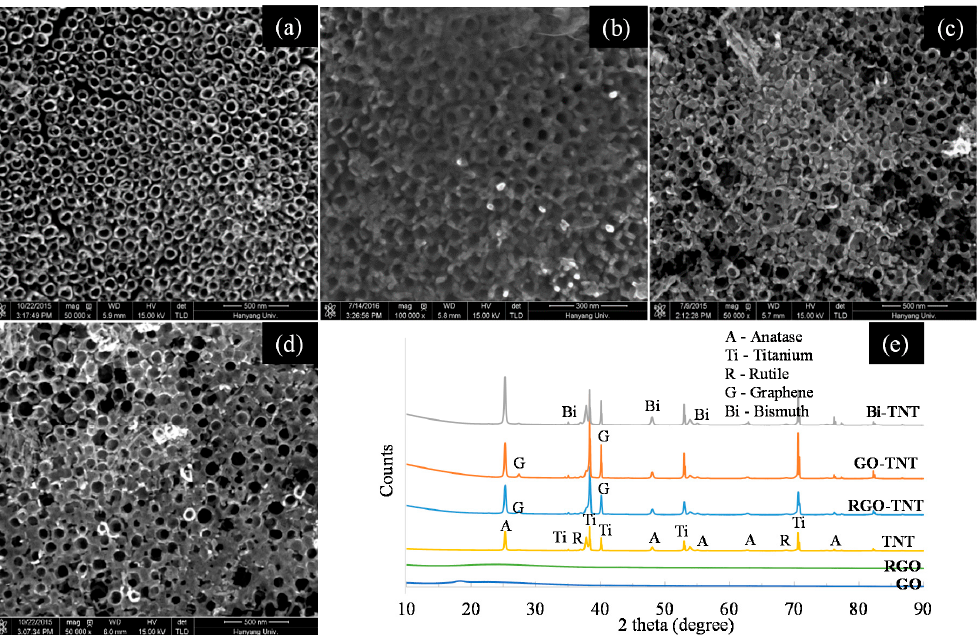
Figure 1. FESEM images of ( a ) TNTs, ( b ) GO ‐ TNTs, ( c ) RGO ‐ TNTs, and ( d ) Bi ‐ TNTs composites; ( e ) XRD